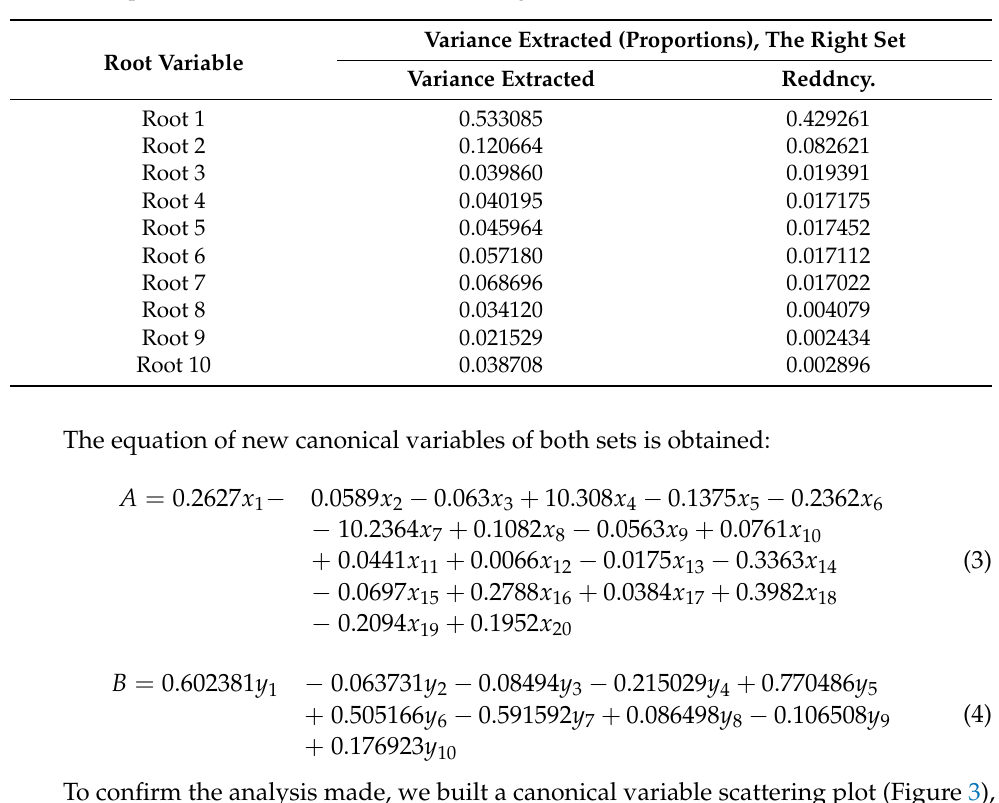
Table 5. Proportions of extracted variance for the right set.